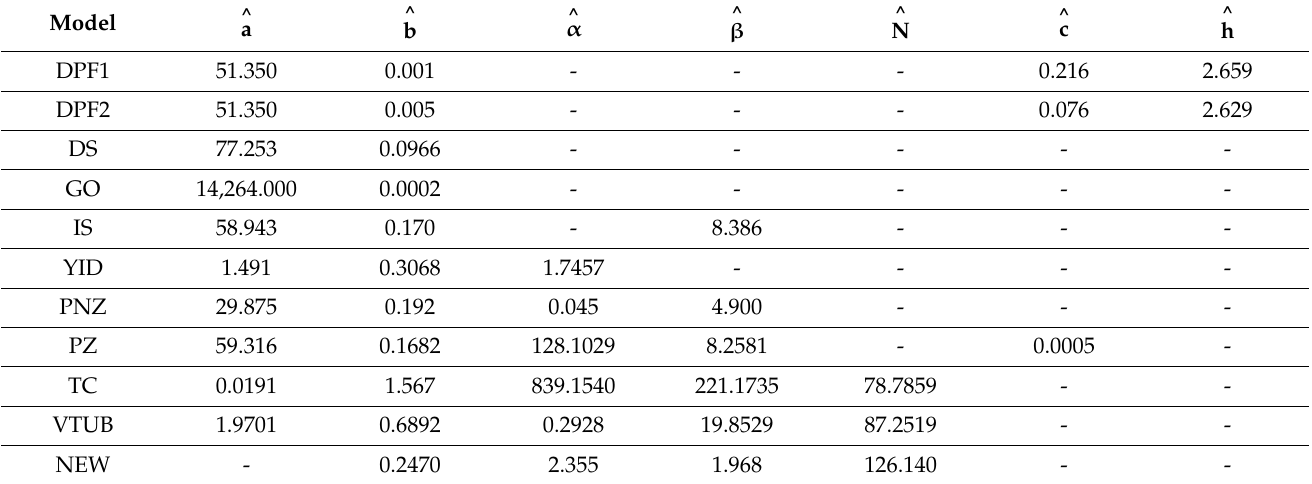
Table 5. Estimated parameters of models for dataset 1.